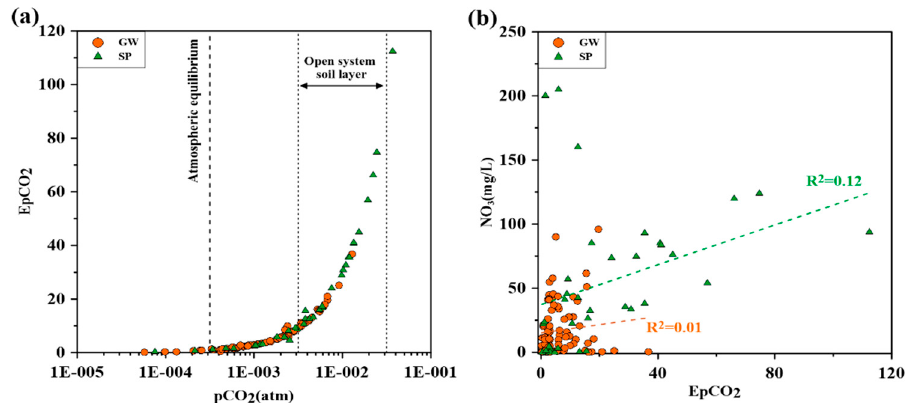
Figure 4. The relationships between pCO 2 and EpCO 2 ( a ), and between NO 3 and EpCO 2 ( b